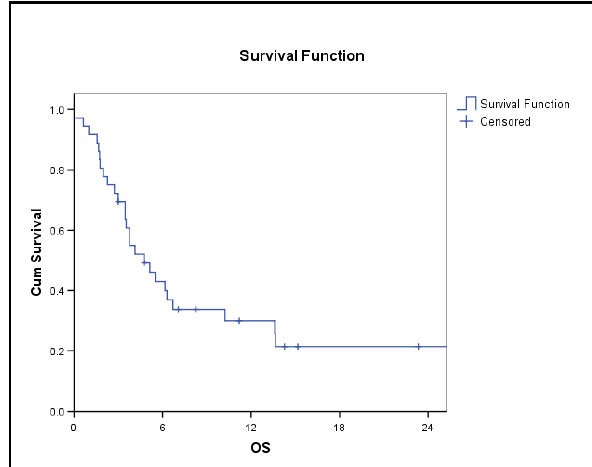
Figure 1. Overall survival curve of 37 lymphoma patients who failed 2 nd line chemotherapy